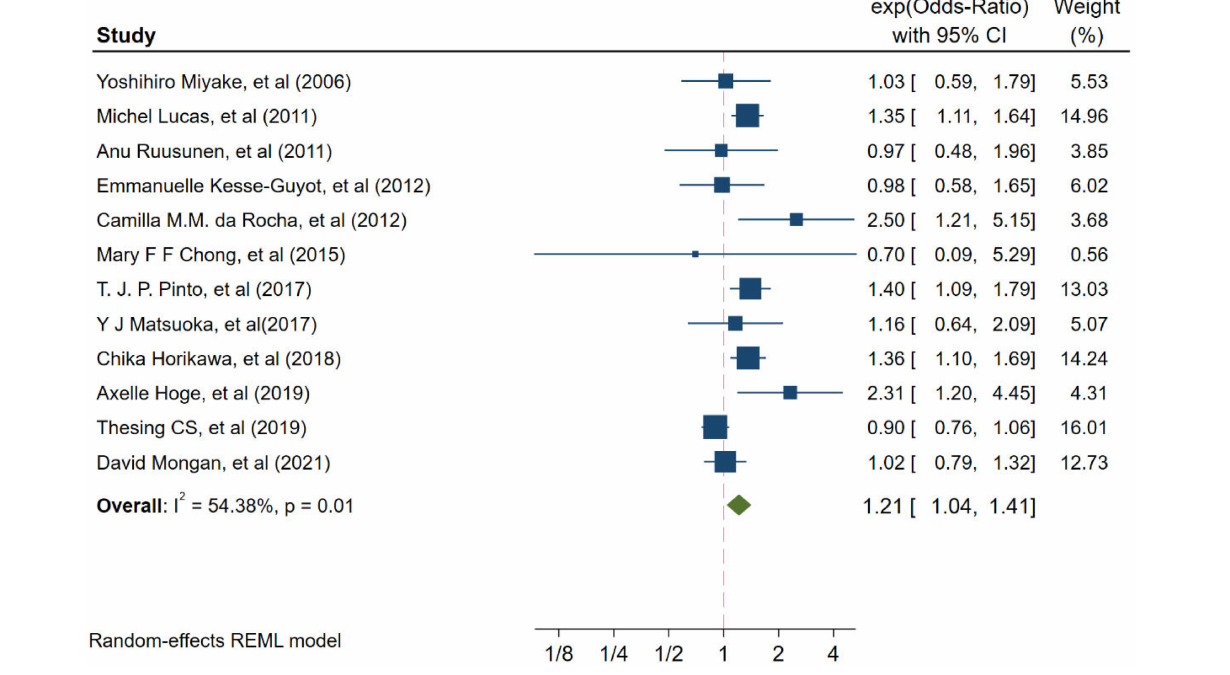
(OR = 1.53, 95CI%: 1.10 ∼ 2.13, I 2 = 36.46%, P = 0.19),